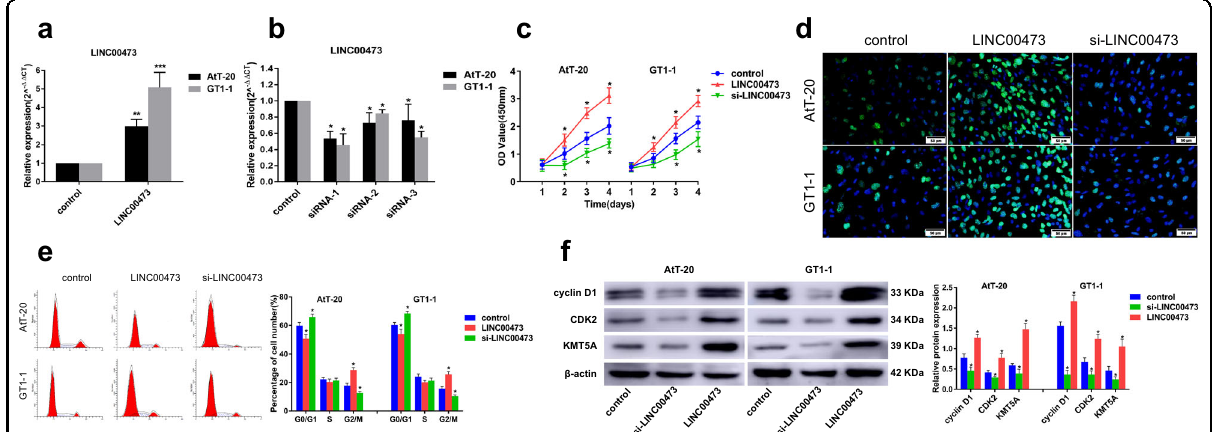
Fig. 3 LINC00473 promotes PA cells proliferation in vitro. qRT-PCR detection of the plasmid ( a ) and siRNA ( b ) transfection ef fi ciency in PA cells AtT-20 and GT1-1. c CCK-8 detection of PA cells viability after overexpression or knockdown of LINC00473. d Cell proliferation was determined by EdU staining. e Cell cycle was analyzed by fl ow cytometry. f Western blot analysis of cyclin D1, CDK2, and KMT5A expression. * P < 0.05, ** P < 0.01, *** P < 0.001, data represent the mean ± SD.